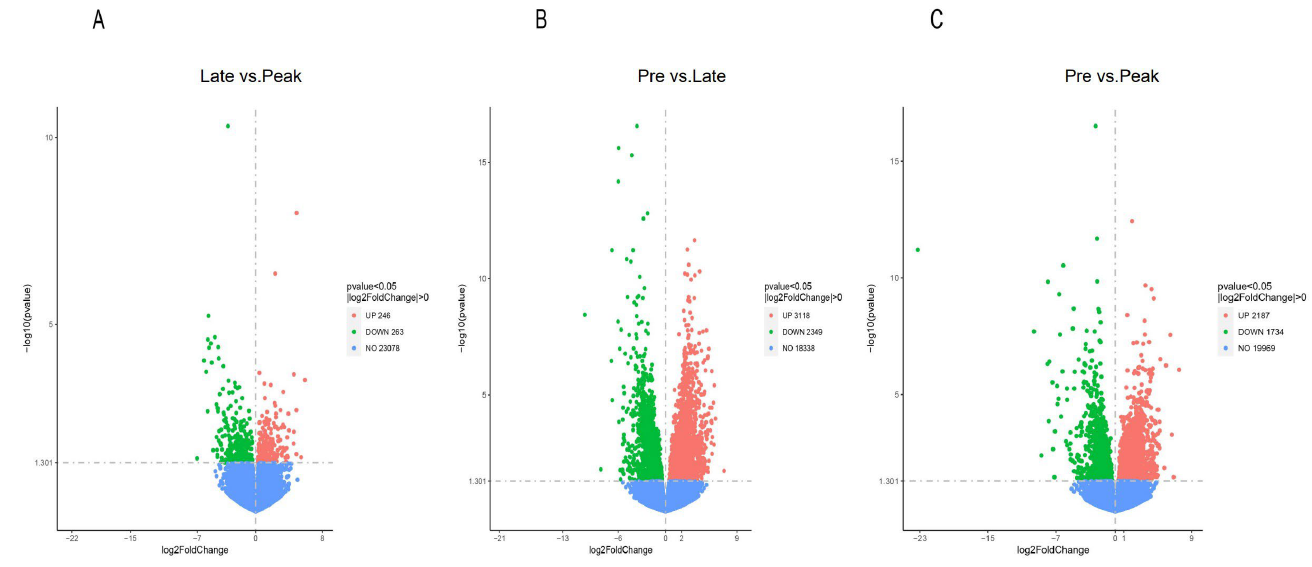
Figure 1. The volcano plot of the DEGs (differential expression genes) in the ( A ) late vs. peak stage, ( B ) pre vs. late stage, and ( C ) pre vs. peak stage. The X-axis means the change of gene multiplicity (log2FoldChange). The Y-axis indicates the significance level of the difference ( − log10pvalue). Red dots: upregulated genes; green dots: downregulated genes; blue dots: non-differential